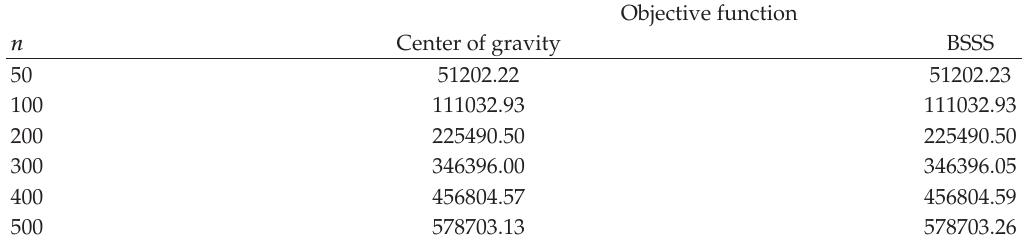
Table 5: The results of Example 4.5 with radius equal to